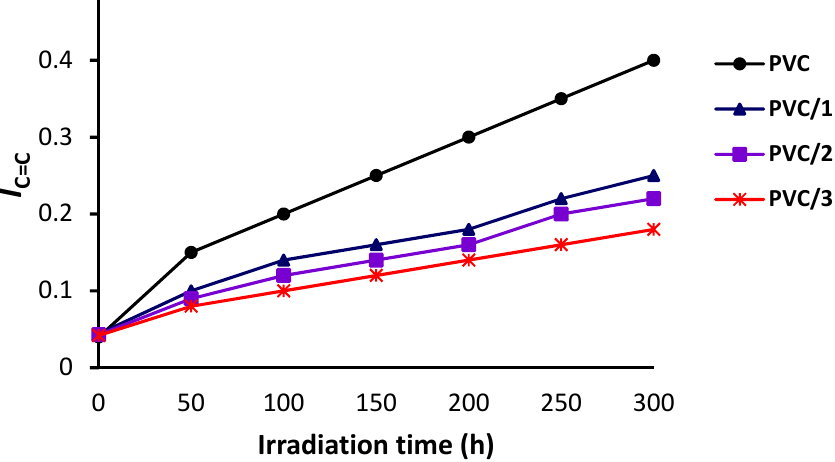
Figure 8. E ff ect of irradiation on the carbonyl group index ( I C = O ) of the PVC films. Figure 8. Effect of irradiation on the carbonyl group index ( I C=O ) of the PVC films.